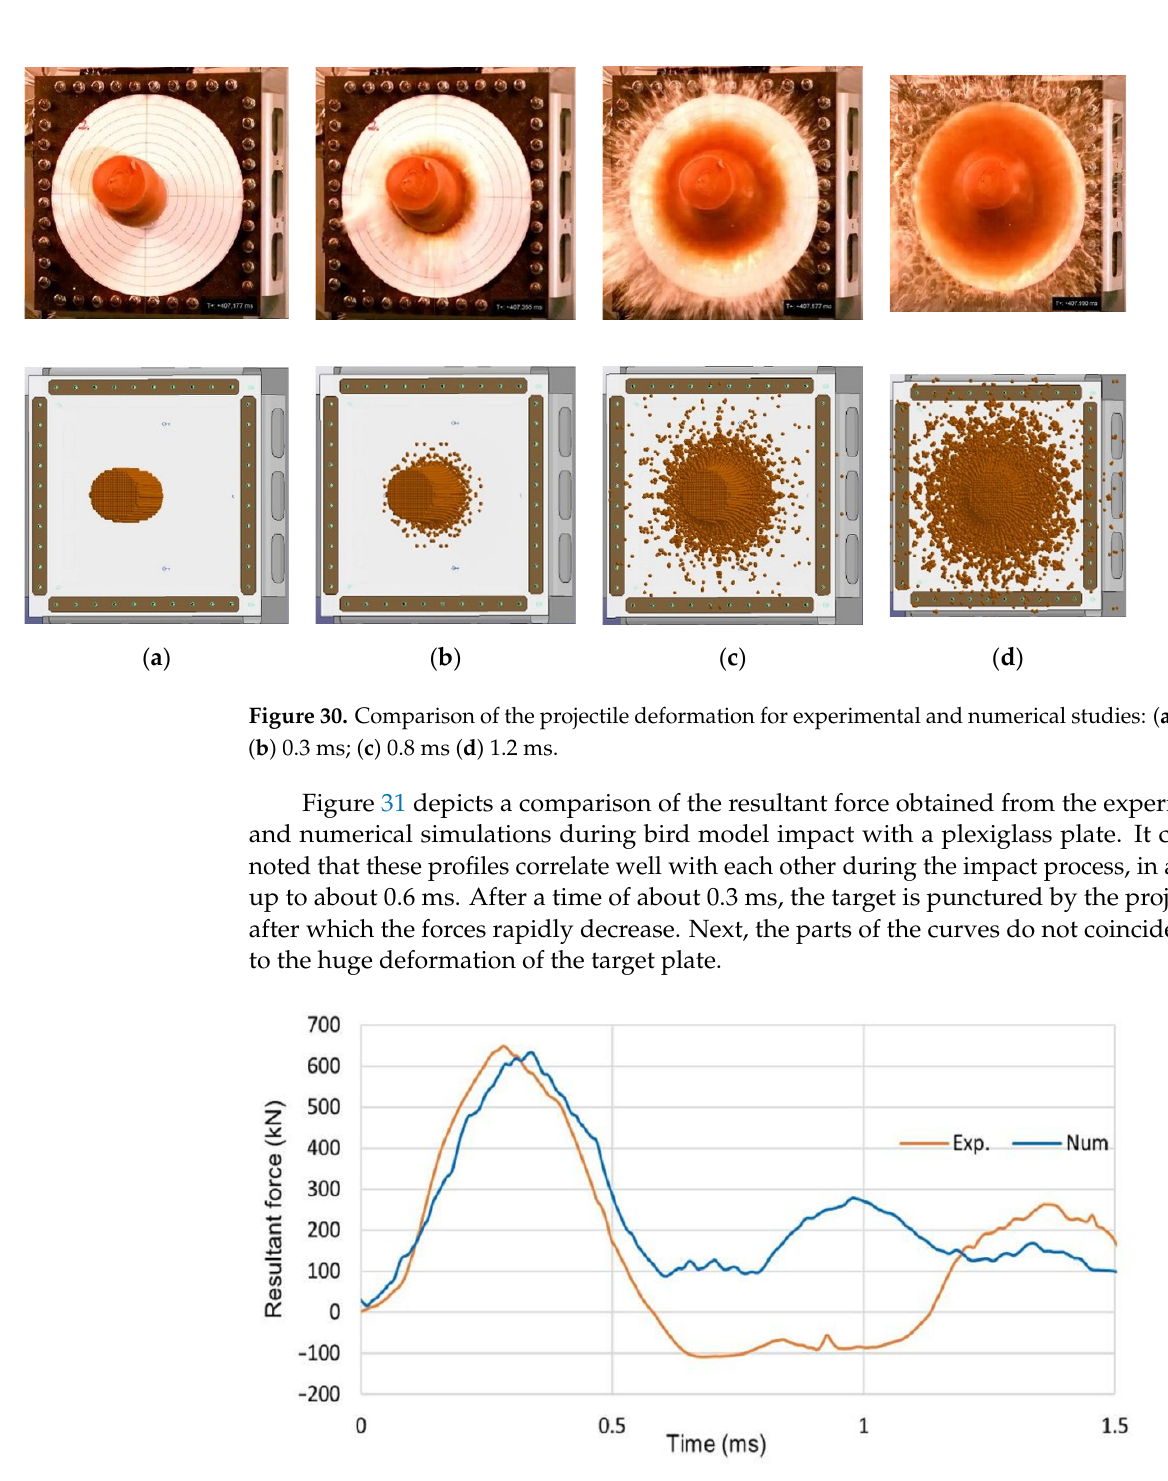
( b ) Figure 32. Distributions of Von Mises stresses before ( a ) and after ( b ) the puncture of the plate. Figure 33 depicts the plot presenting the distributions of the Von Mises stresses of two elements, one is located in the center of the plate and the other is located 0.1 m from the center. The location of element no. 1 was chosen to show the course of the stress in the moment of the puncture. It can be observed that the maximum value of the stress (60 MPa) in element no. 1 occurs at the moment of the puncture, and it coincides with the value shown in Figure 32a. After the puncture the stress rapidly decreases to zero, the same situation is shown in Figure 32b. Taking into account element no. 2, which is 0.1 m far from the center, the course of the stress curve is different. The maximum value of the stress